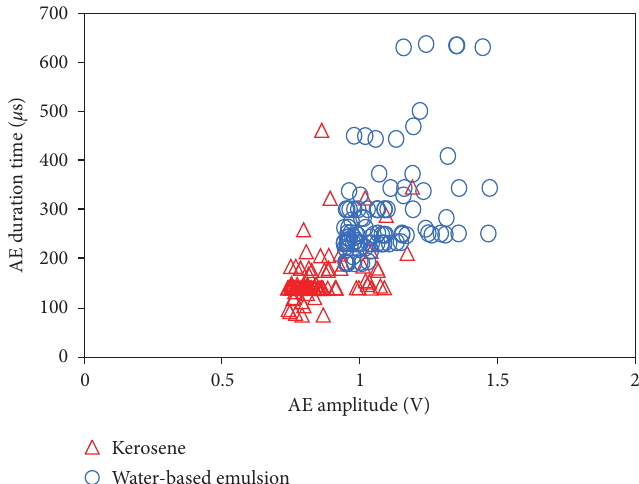
Figure 8: Comparison of AE duration and amplitude for discharge in kerosene and water-based emulsion. Characteristic analysis for discharge in water-based